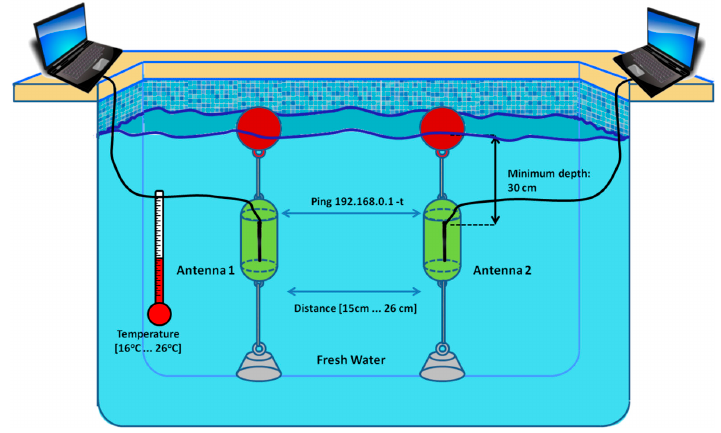
Figure 7. Swimming pool where measures have been taken.